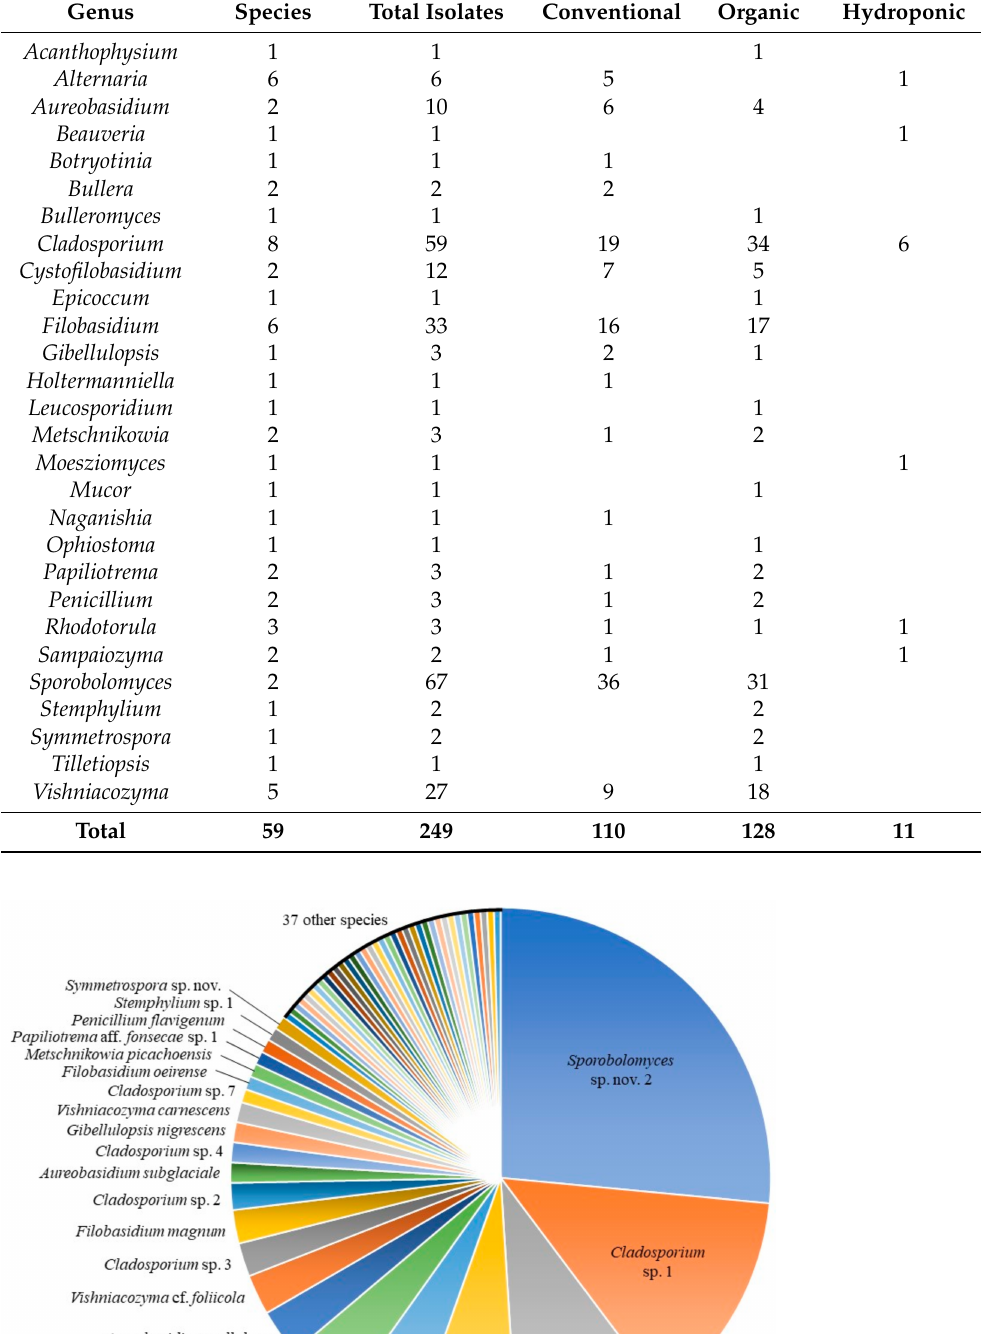
Table 2. All genera obtained from romaine lettuce samples in this study, with number of species, number of total isolates and number of isolates by treatment (conventional, organic, hydroponic).